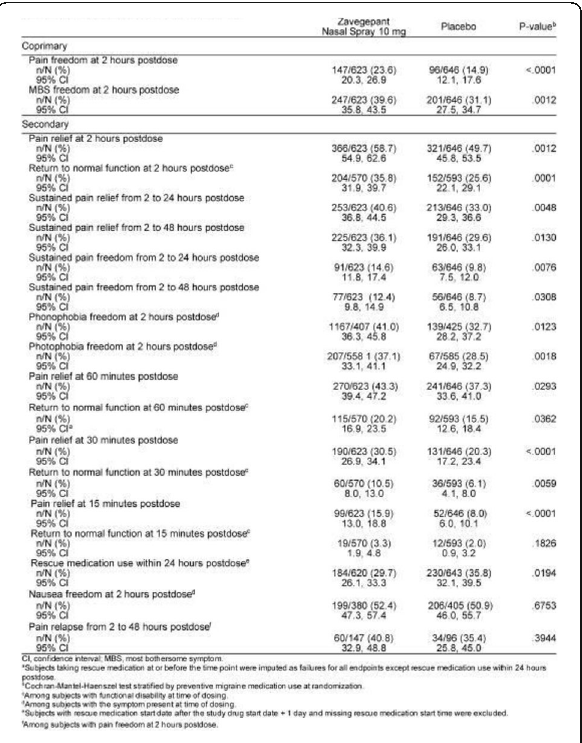
Fig. 1 (abstract P136a). Zavegepant Nasal Spray versus Placebo in the Acute Treatment of Migraine: Summary of Results on Coprimary and Secondary Efficacy Endpoints. *